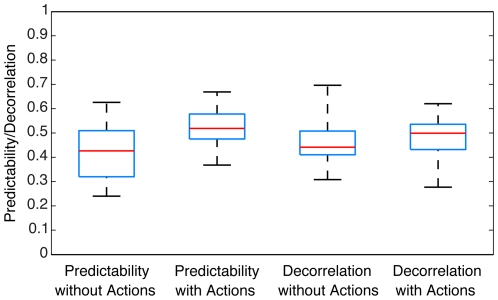
Comparison of the predictability and decorrelation of state configurations generated with and without the knowledge of the agent's motor capabilities.The horizontal lines in each box represent the 25th, 50th (median) and 75th percentiles, while the black whisker bars mark the range of the data.